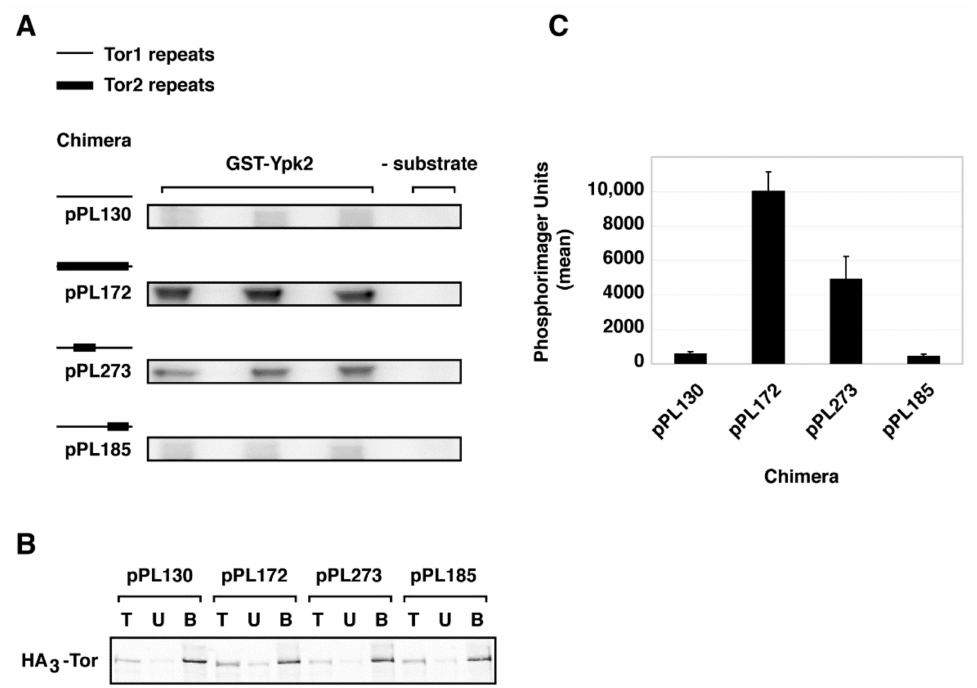
Figure 6. Recognition of TORC2-specific substrate Ypk2 by chimera 273. ( A ) Autoradiograph of triplicates of in vitro kinase reactions using immuno-purified complexes containing indicated chimeras and recombinant GST-Ypk2. ( B ) Western blot of loading controls demonstrating that essentially equivalent amount of TOR chimeras were present in the immunoprecipitated complexes (bound ( B ) fractions) used for kinase reactions. ( C ) Quantification of data in ( A ), where total phosphorimager units are indicated. Data are presented as means +/ − standard deviation (SD) of the triplicate samples shown in ( A ) and were normalized for levels of Tor protein